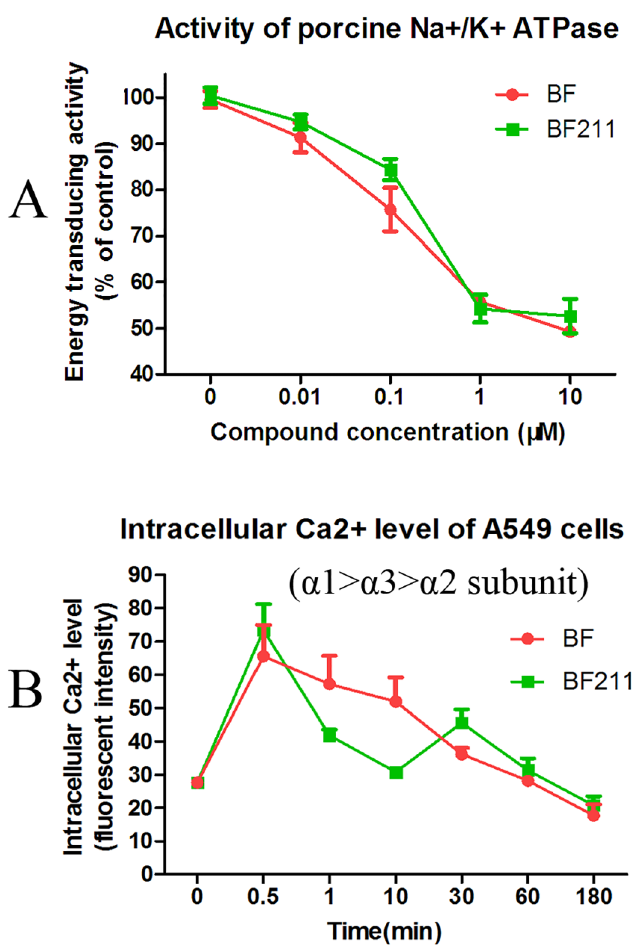
Fig 4. Inhibitive effects of BF or BF211 on the activity of porcine cortex Na+/K+-ATPase and the intracellular Ca2+ level of A4549 cells. (A) The activity of Na + /K + -ATPase extracted from porcine cerebral cortex in the presence of BF or BF211 at different concentrations was determined. The data are the statistical results (n = 3, mean ± SEM) of three independent experiments. (B) The level of intracellular Ca2+ level in A549 cells treated with 50 nM BF or BF211 for different time periods. The data are the statistical results (n = 3, mean ± SEM) of three independent